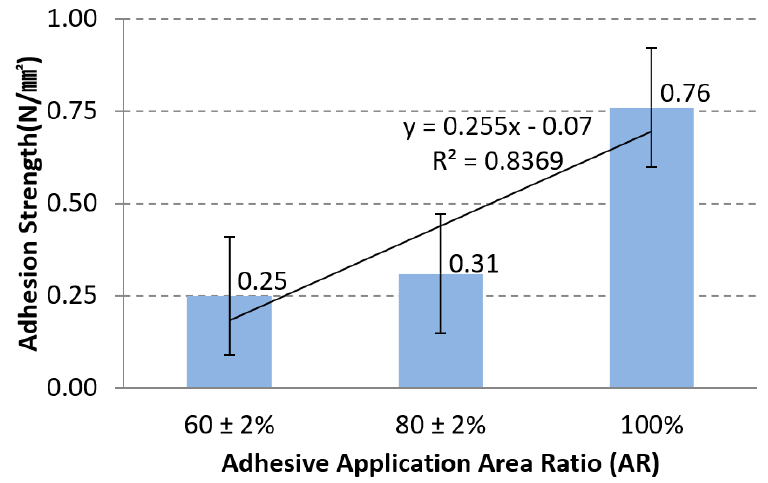
Figure 18. Average adhesion strength change linear regression based on the spot-bonding surface area.